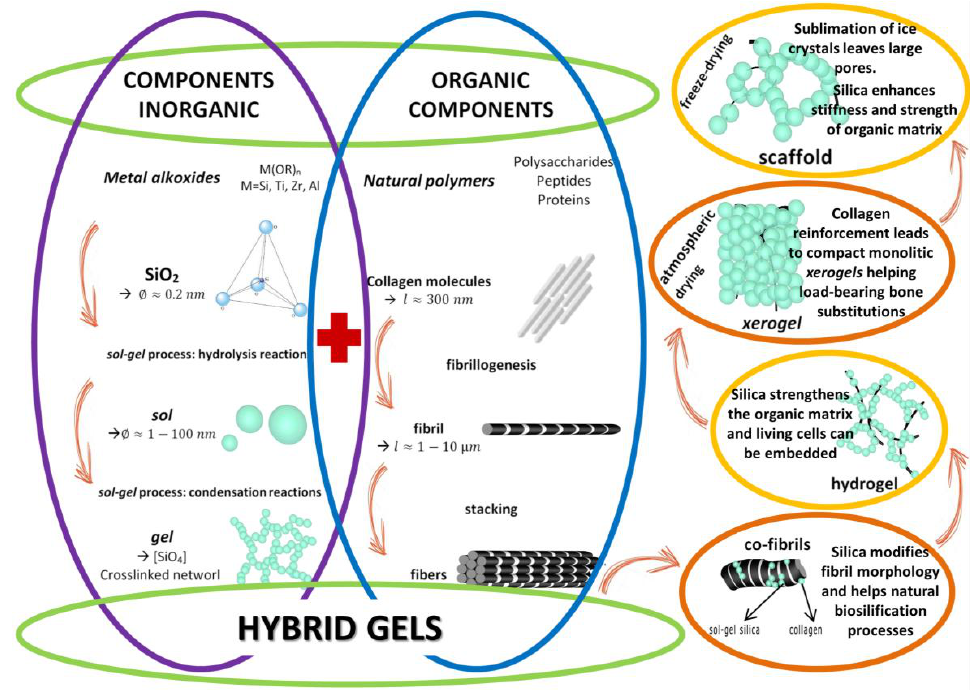
Figure 8. Advantages of hybrid gels . From soft mineralized hydrogels to hard compact xerogels . Original illustration designed and provided by the authors.